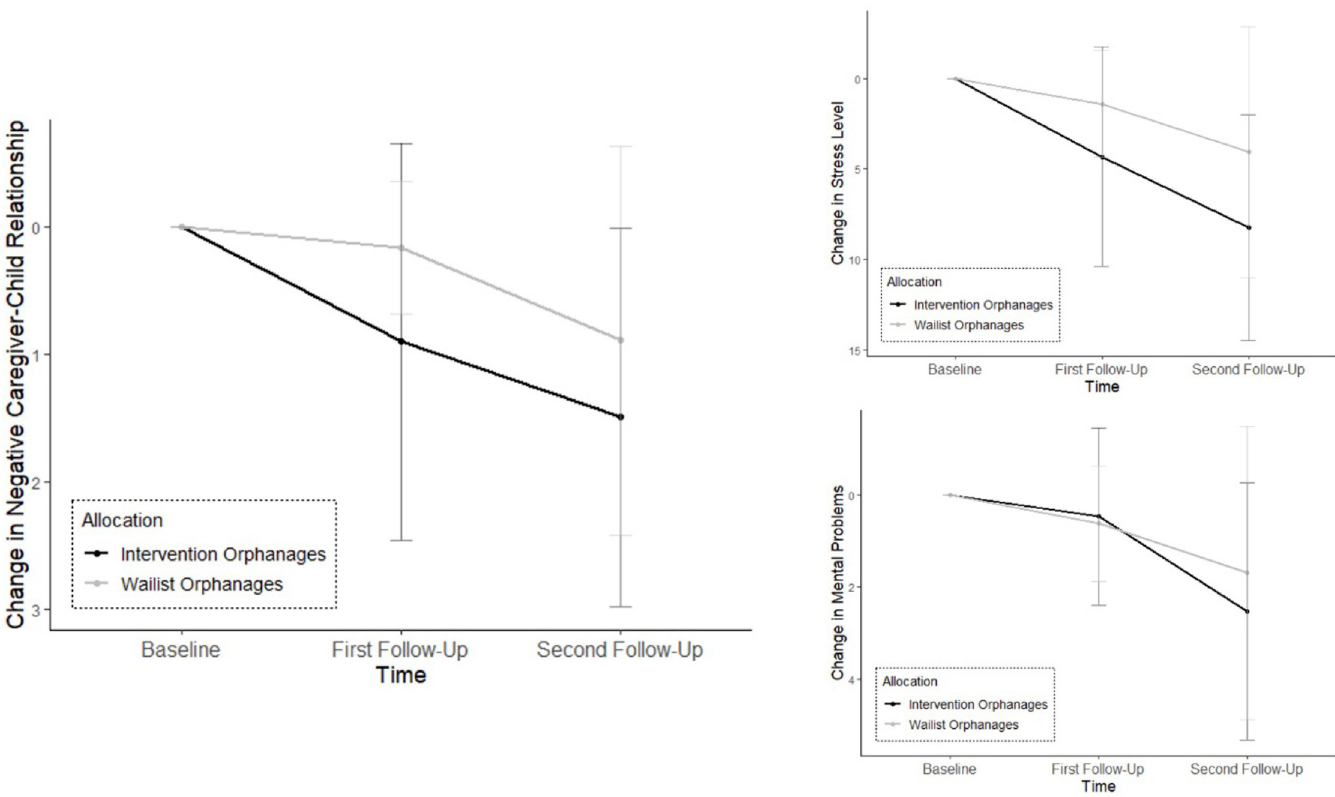
Fig 3. Change in secondary outcomes over time separated by intervention and waitlist orphanages. The graphic displays the trimmed and transformed means ( M and standard deviations ( SD ab ) for negative caregiver-child relationship, stress level and mental problems at all three time points. The values for first and second follow-up show the respective difference to the baseline value. A positive difference indicates a decrease while a negative difference stands for an increase of the respective outcome measure over time. Note that the y-axis was mirrored for a more intuitive understanding. The graphic illustrates: One year after participating in ICC-C , the intervention orphanages show significant decreases in negative caregiver-child relationship, stress level and mental problems.